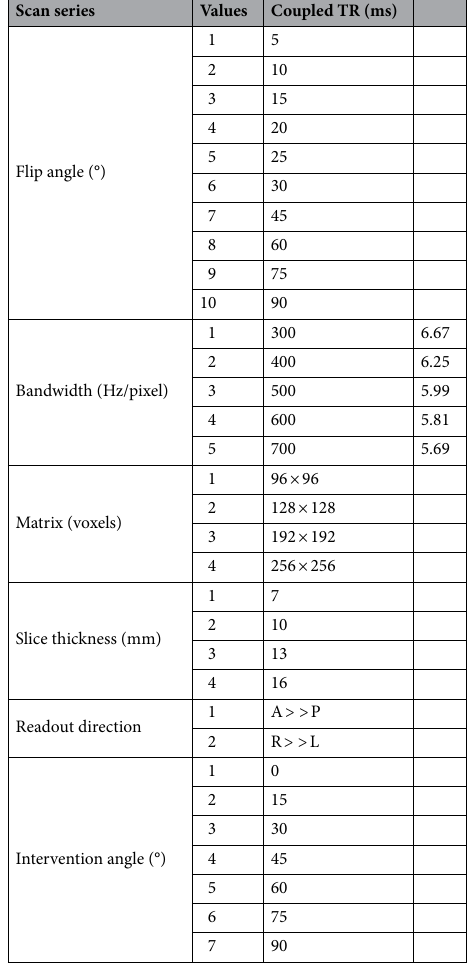
Table 4. Flowchart. Scan series of study profile. Systematic and sequential modification of the intervention angle and of the technical parameters of T1-weighted GRE sequences. TR repetition time, Hz Hertz, A anterior, P posterior, R right, L